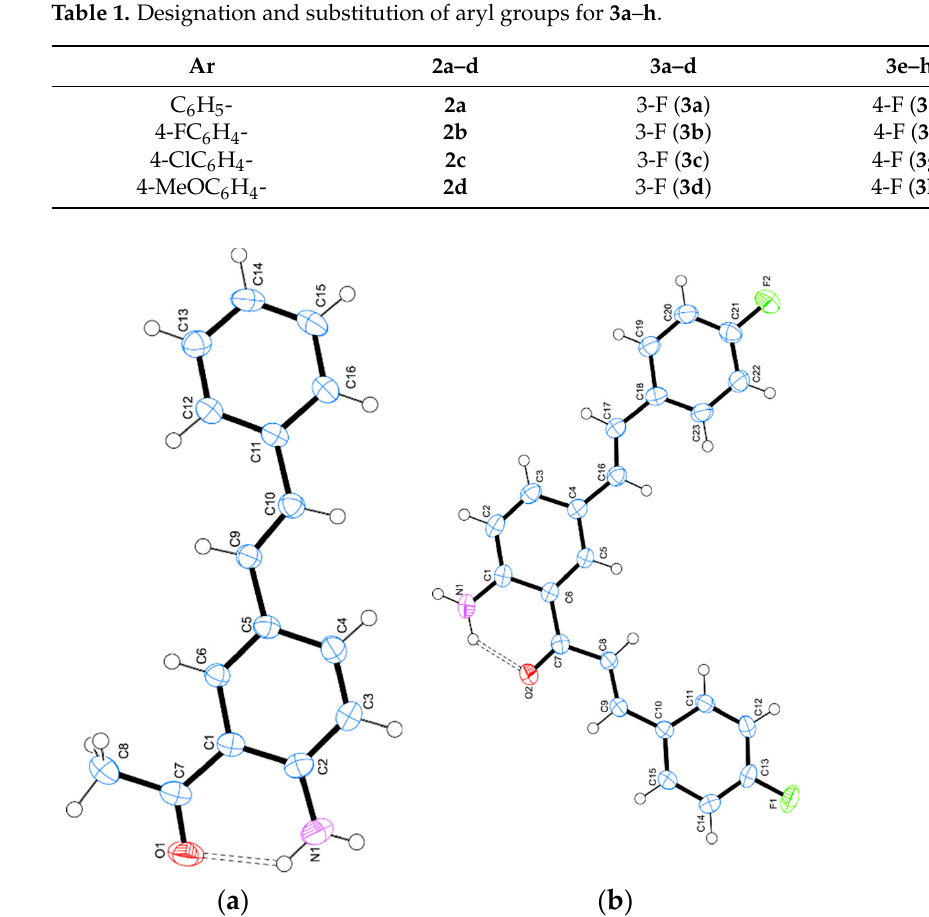
Figure 2. Molecular structure of compound 2a ( a ) and 3f ( b ) determined from single-crystal X-ray data, showing the atom-labelling scheme, which differs from systematic numbering.